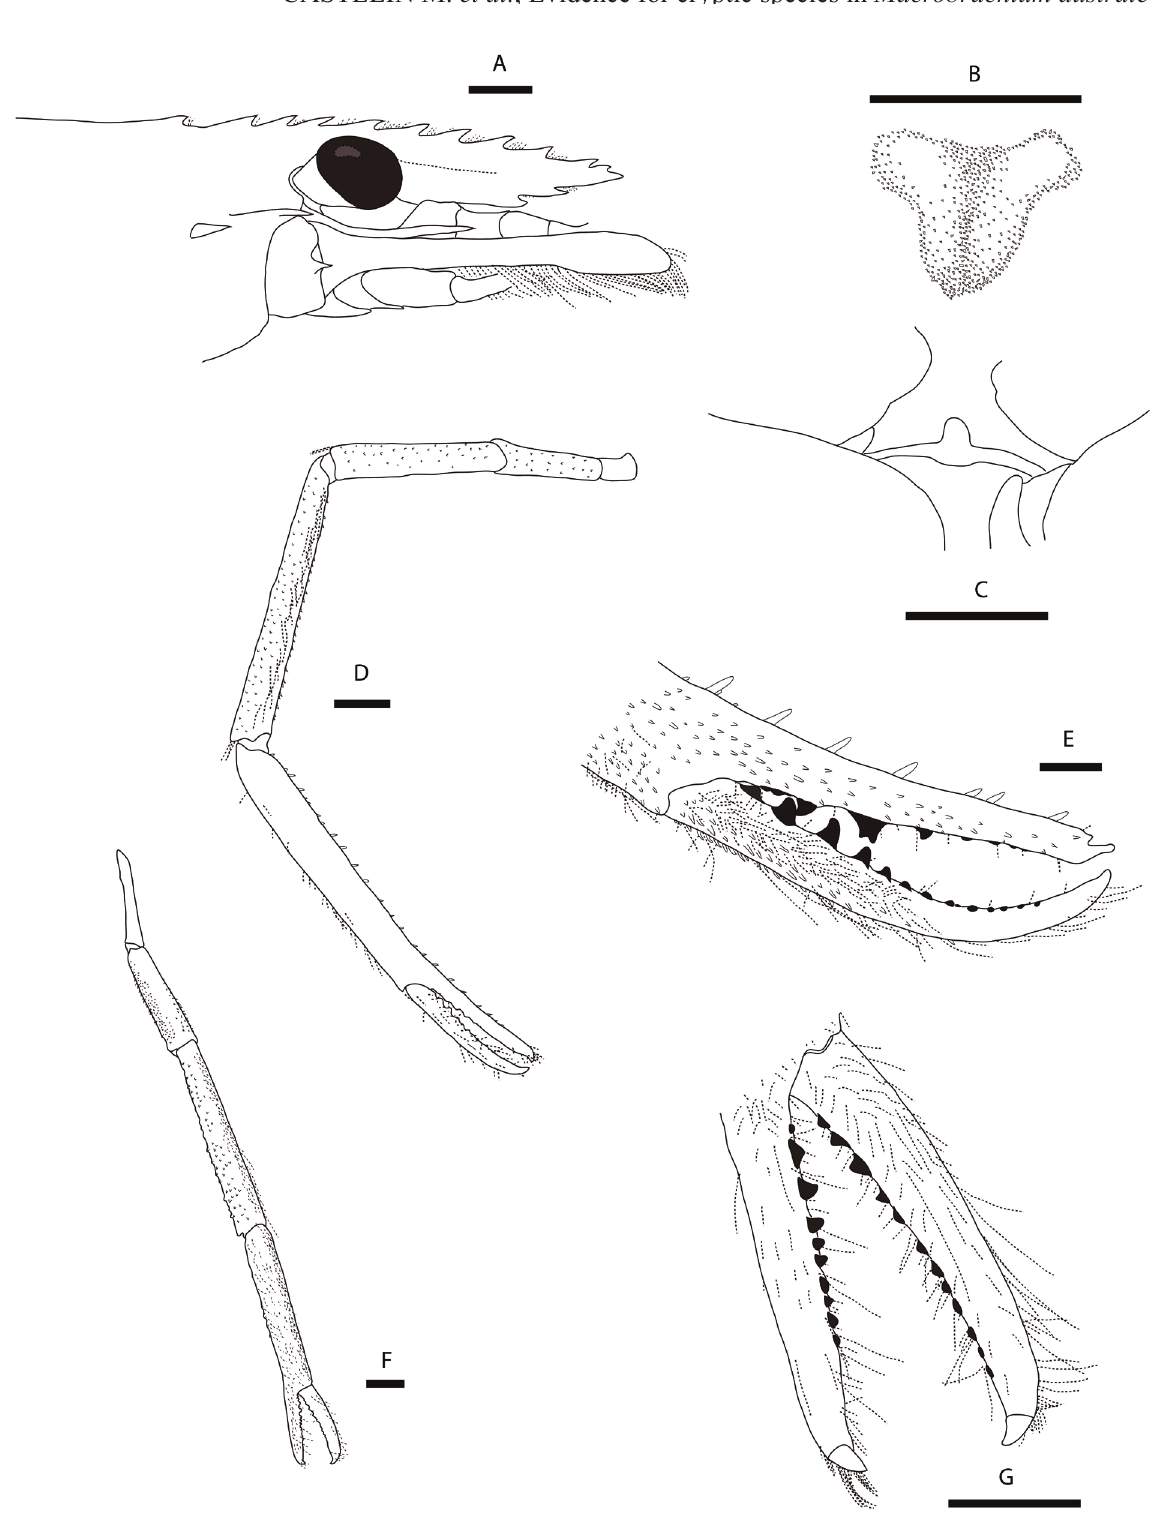
Fig. 5. Macrobrachium ustulatus (Nobili, 1899). – A–B, E . MNHN-IU-2013-13202. A . Cephalothorax. B . Epistome. E . Major second pereiopod finger. – C, G . MNHN-IU-2013-13201. C . Fourth thoracic sternite. G . Minor second pereiopod finger. – D, F . MNHN-IU-2013-13203. D . Major second pereiopod. F . Minor second pereiopod. Scale bars: A, E, G = 2 mm; B–C = 1 mm; D, F = 4